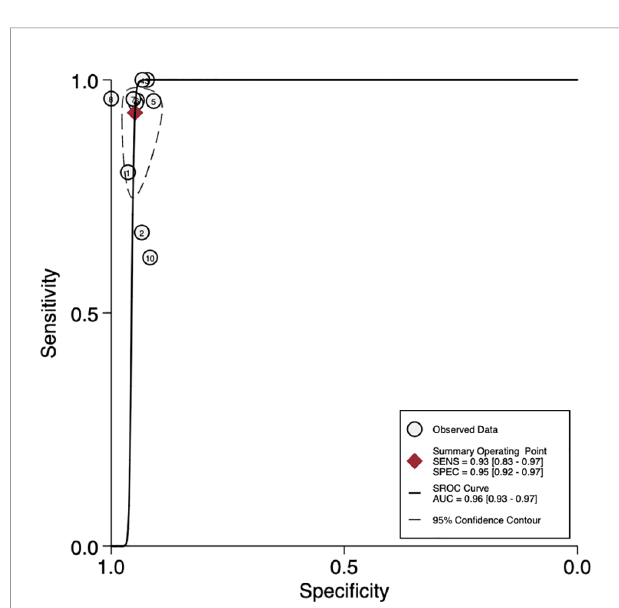
FIGURE 3 | Forest plots for studies on overall mNGS used in the diagnosis of PJI. CI, con fi dence interval.